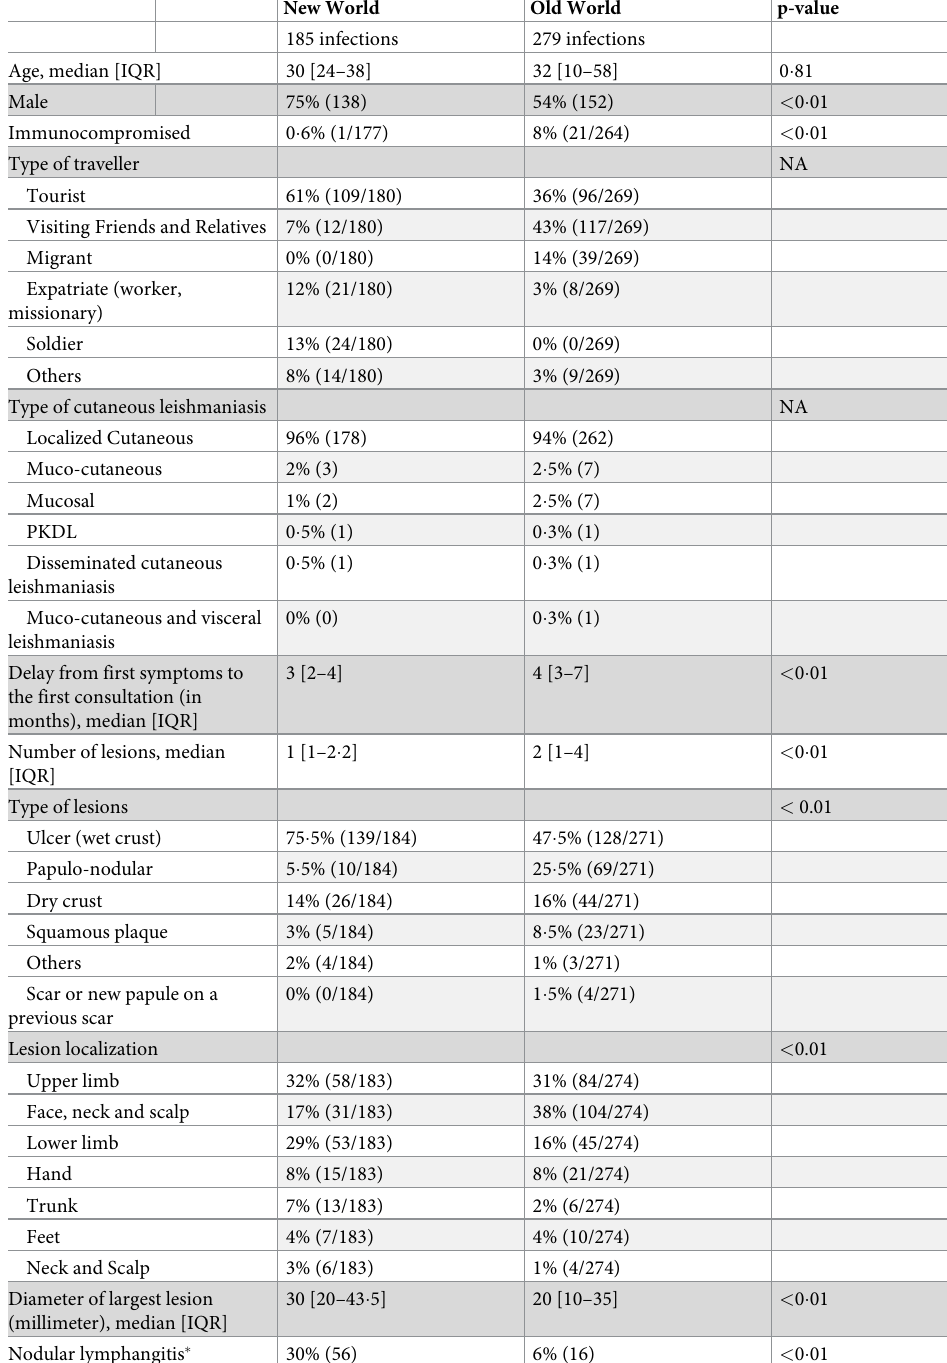
Table 1. Comparative features of cutaneous leishmaniasis by continent(s) of acquisition.